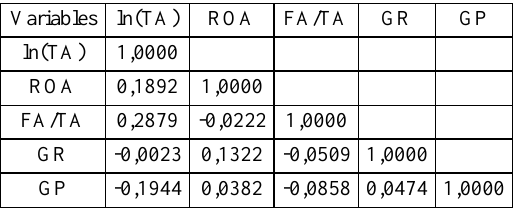
Table 2. Correlation Matrix of Independent